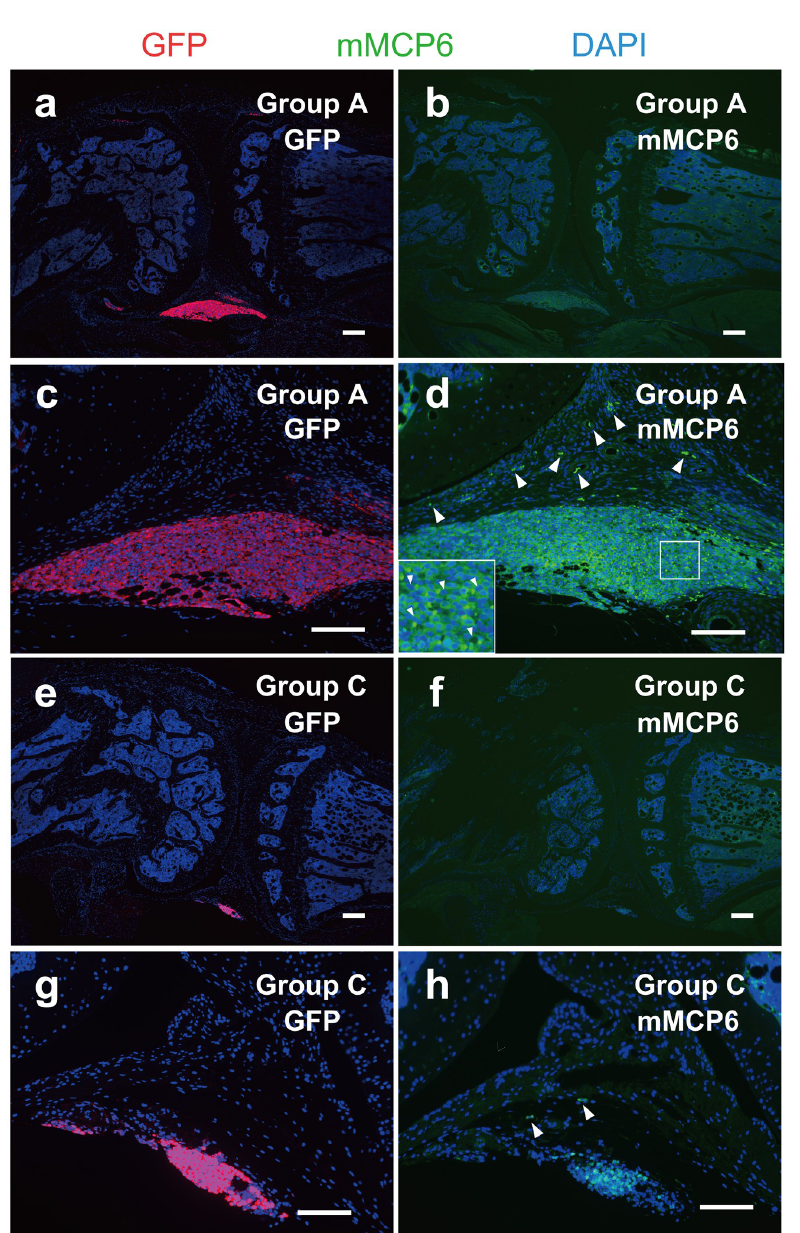
Fig 5. Localization of GFP-labeled BMMCs in the knee joints. Knee joints were excised from mice belonging to group A and C on day 15 (24 h after injection of GFP-labeled BMMCs). Neighboring sections were stained with anti- GFP antibody (red) (a, c, d, and g) or anti-mMCP6 antibody (green) (b, d, f and h) according to the methods described under Materials and methods. In inset of d, an enlarged image of the area surrounded by a square was shown. In this inset, degranulated BMMCs were indicated by small arrowheads. Endogenous mast cells that were positive to mMCP6 but negative to GFP were indicated by arrowheads in d and h. Original magnification was x40 (a, b, e, f) and x200 (c, d, g, h). Bars indicate 200 μ m (a, b, e, f) and 100 μ m (c, d, g, h). tryptase from BMMCs in a dose-dependent manner (Fig 11b). Taken together, it may be possi- ble that extracellular ATP is involved in the enhancement of spontaneous pain elicited by BMMCs through, at least partly, activation and degranulation of BMMCs. We also tried to show that extracellular ATP was actually increased in the synovial fluid of the OA knee joints.